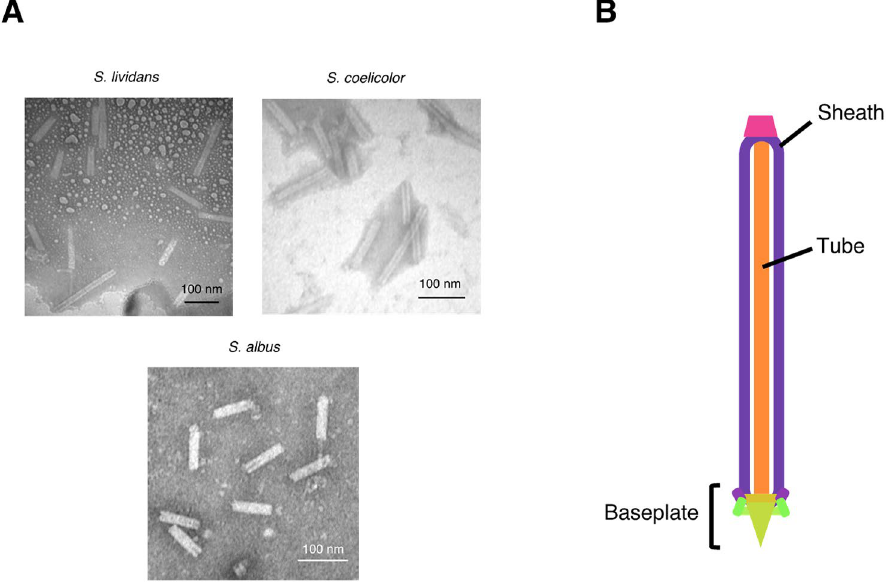
Figure 2. Streptomyces species produce eCIS-like nanostructures. eCIS-like nanostructures were found in the mycelial extracts of Streptomyces species. ( A ) TEM of the mycelial extracts of S. lividans , S. coelicolor , and S. albus . Scale bars, 100 nm. ( B ) Putative structure of the eCIS-like particle of S. lividans . This model is based on Cryo-EM structures of Gram-negative bacterial eCISs (10,11). Each color of the components corresponds to that shown in Fig.